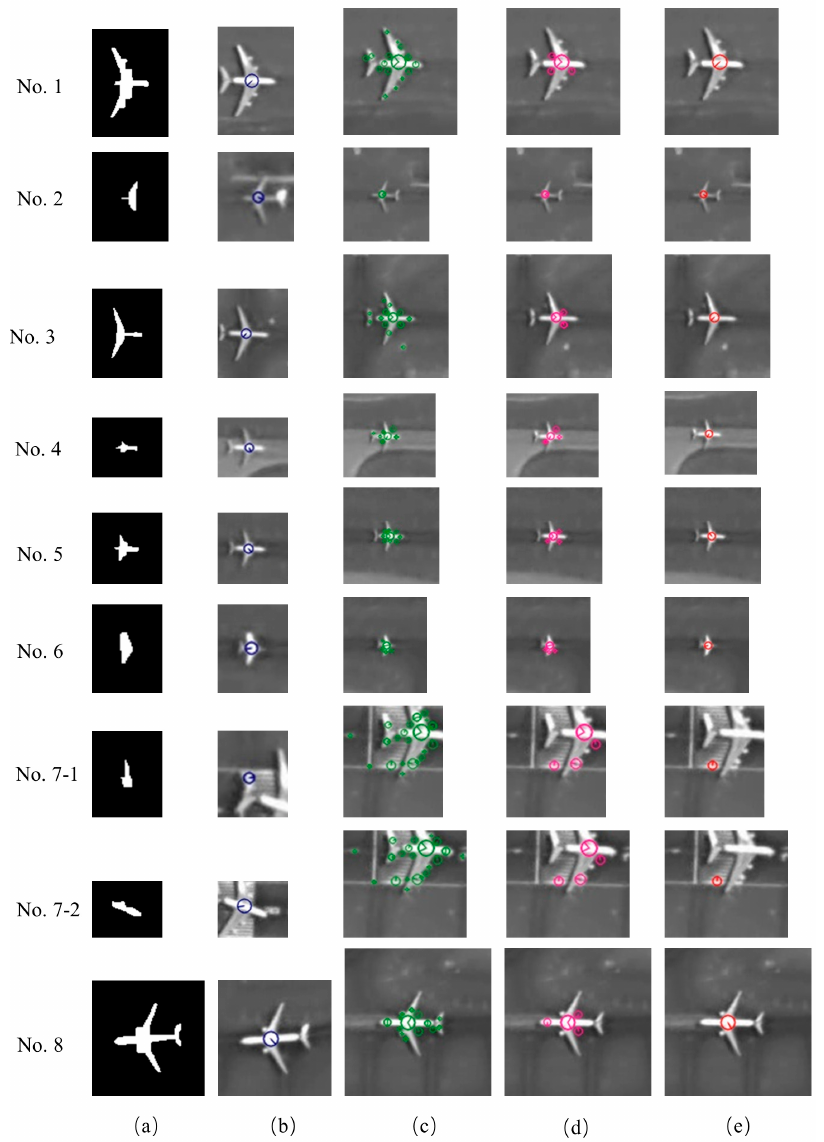
Figure 7. Tracking results of the developed P-SIFT keypoint matching algorithm: ( a ) masks of moving airplanes; ( b ) P-SIFT keypoints (blue circles) the templates extracted from F 0 ; ( c ) SIFT keypoints (green circles) inside the ROS extracted from the last tracking sample frame; ( d ) SIFT keypoint candidates (magenta circles) selected from ( c ); and ( e ) the most matched SIFT keypoint (red circles).